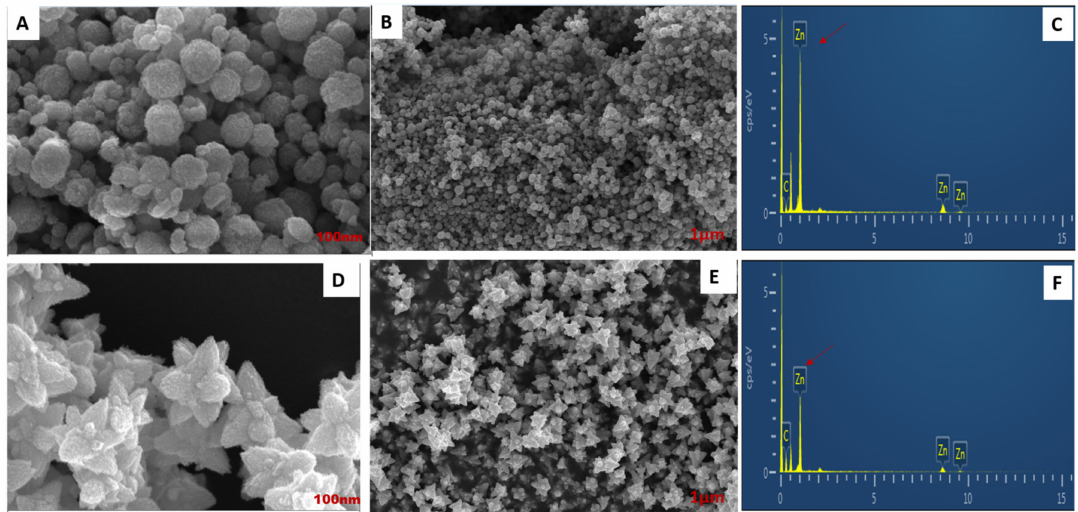
Figure 6. FE-SEM analysis of DM -ZnO nanoparticles exhibited a spheroid shape in ( A ), ( B ) and DM -ZnO-I3C nanoemulsion exhibited a flower shape in ( D ), ( E ) EDS analysis for DM -ZnO NPs ( C ) and DM -ZnO-I3C-NE ( F ).